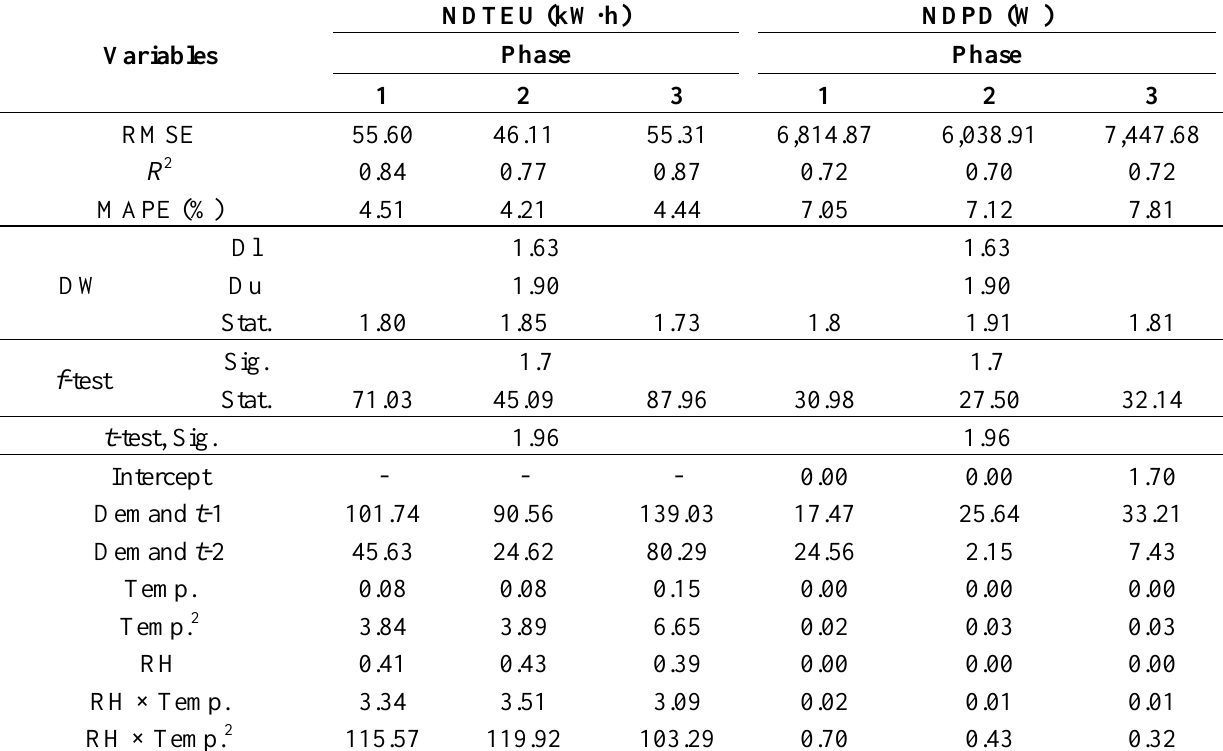
Table 2. ARIMAX hindcast statistics. RMSE: root mean square error; MAPE: mean absolute percentage error; and DW: